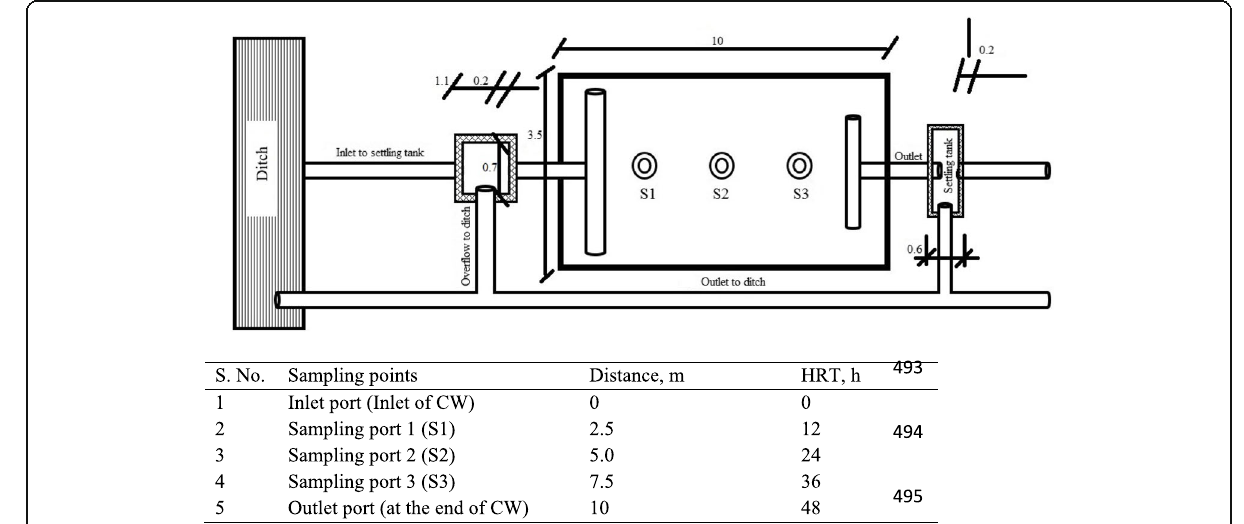
Fig. 1 Dimensions and sampling port for the experimental